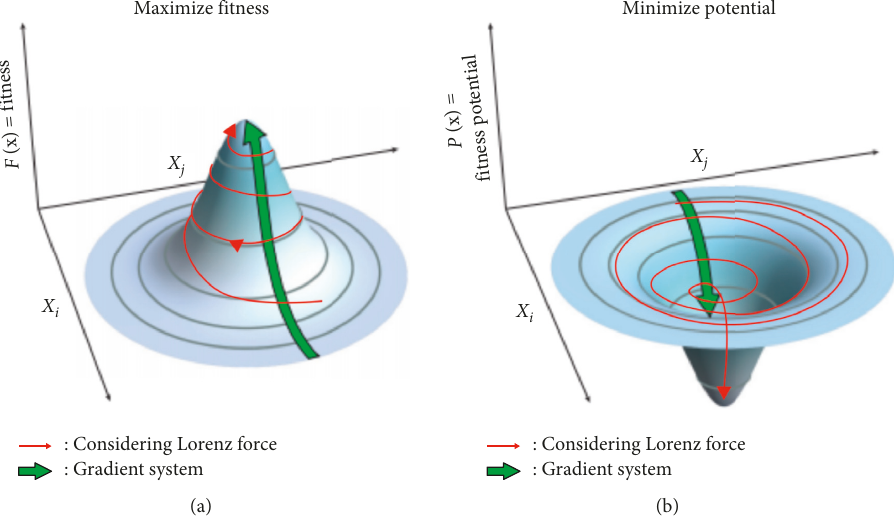
Figure 1: Evolution is described as populations moving on landscapes. This is represented as either (a) a maxima on a landscape of fitness; or (b) a minima on a landscape of fitness potential. They are different ways to visualize the same